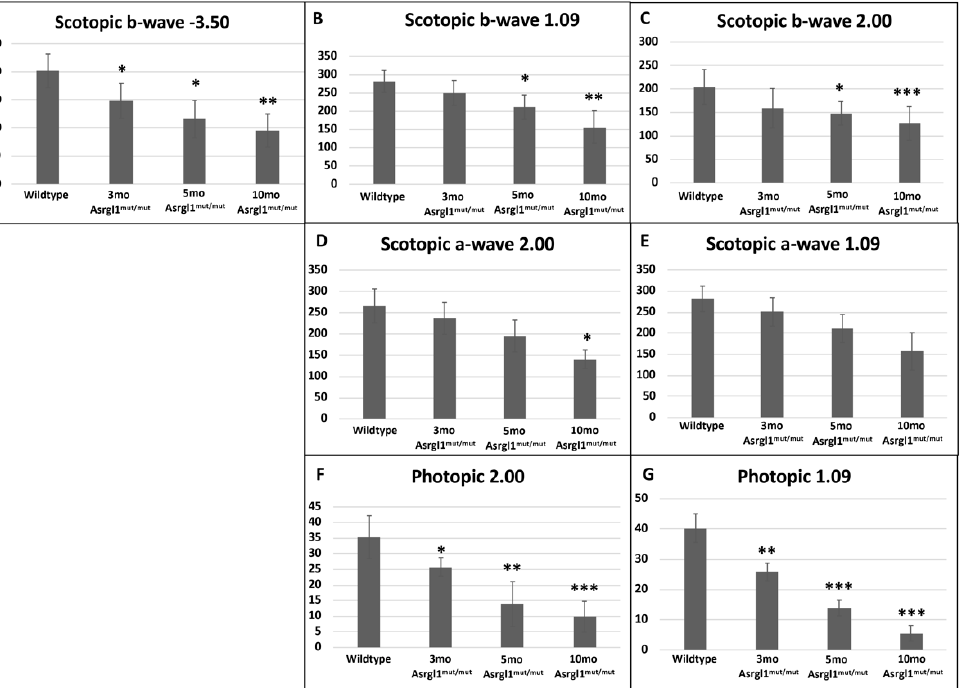
Figure 3. Full-field electroretinography (ffERG) responses in Asrgl1 mut/mut mice model: Average scotopic and photopic ERG a- and b-wave amplitudes for 10-month-old wildtype control mice compared with 3-, 5-, and 10-month-old Asrgl1 mut/mut mice at − 3.50 log cd.s/m 2 , 1.09 log cd.s/m 2 , and 2.00 log cd.s/m 2 stimulation intensities. Vertical lines on the bar graphs represent standard error mean. The p values < 0.05, 0.01, and 0.001 are indicated with *, **, and ***, respectively.